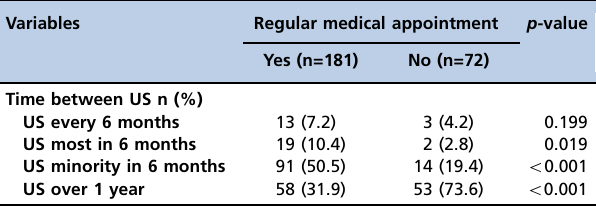
Table 2 - Evaluation between regular medical appointment and ultrasound performance for hepatocellular carcinoma screening. Variables